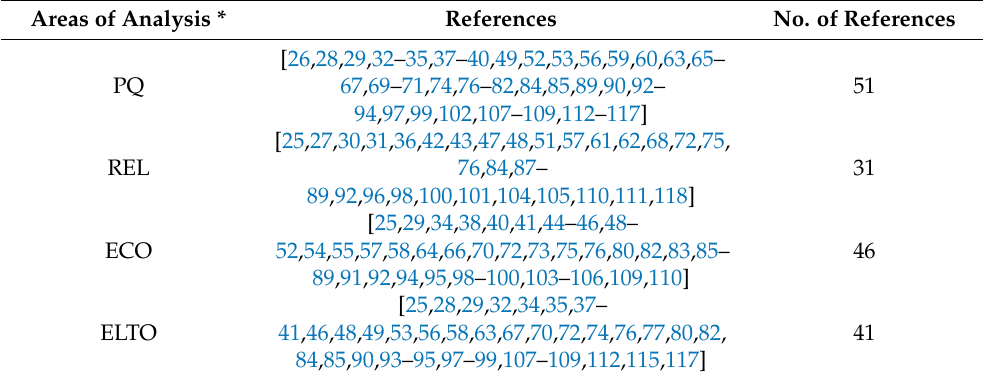
Table 2. Classification of the reviewed papers—areas of analysis of electrical networks. Areas of Analysis